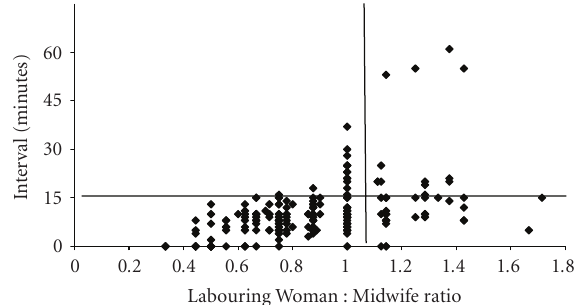
Figure 8: Transfer time to theatre versus Labouring Woman: Midwife ratio (grade 2).